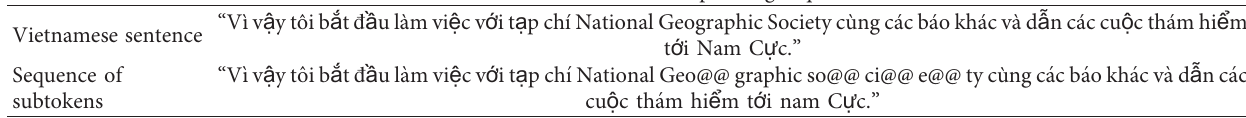
Table 3: A Vietnamese sentence and its corresponding sequence of subtokens.